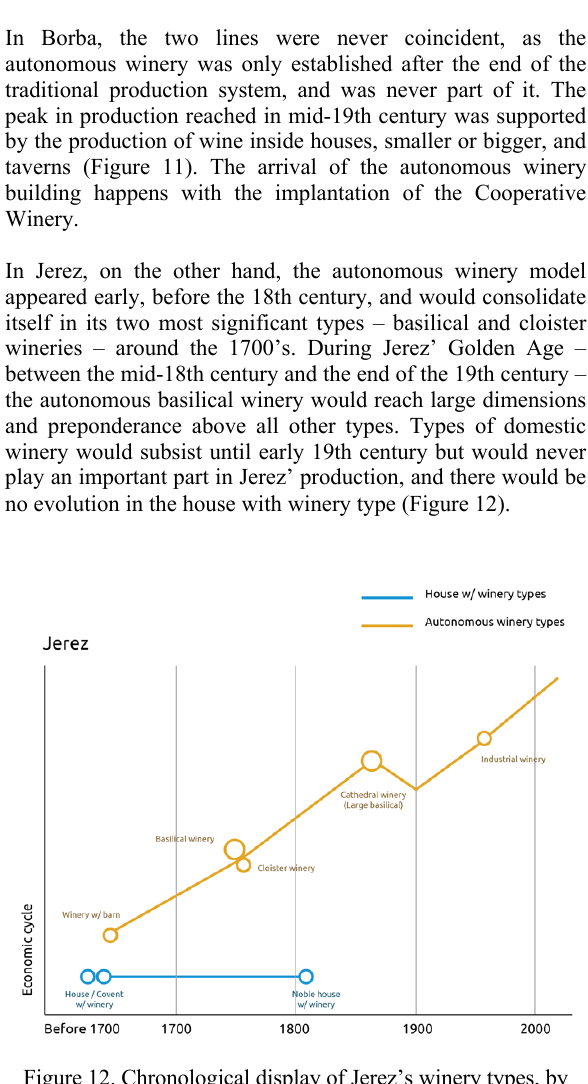
Figure 12. Chronological display of Jerez’s winery types, by typological line of